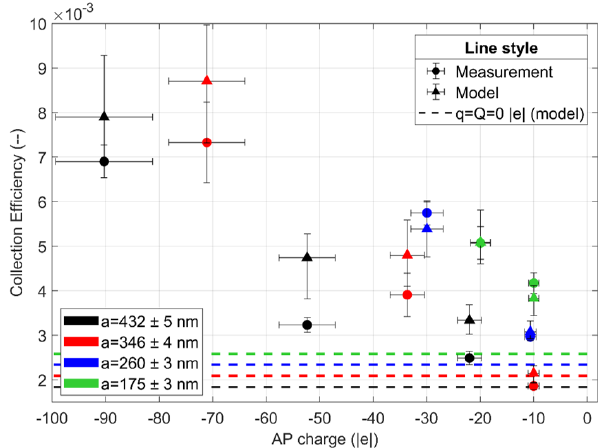
Figure 8. CE measurement (circle) as a function of the AP charge ( q ) for the four wet AP radii (colour code). The respective mod- elled CEs are also presented (triangle). The droplet is neutral with a radius of 48 . 5 ± 1 . 1µm. The experimental conditions are sum- marised in Table 5. The dashed line represents the theoretical CE value disregarding the electrostatic forces (given the air parameters 1 ◦ C, 1atm, 95% of relative humidity). The vertical error bars for the modelled CEs consider the AP and droplet charges uncertain- ties.